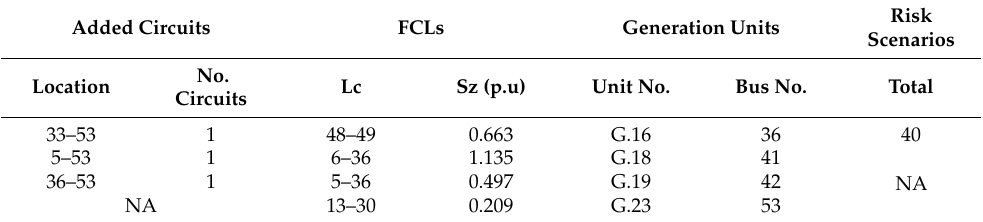
Table 4. Configuration of WDN without considering